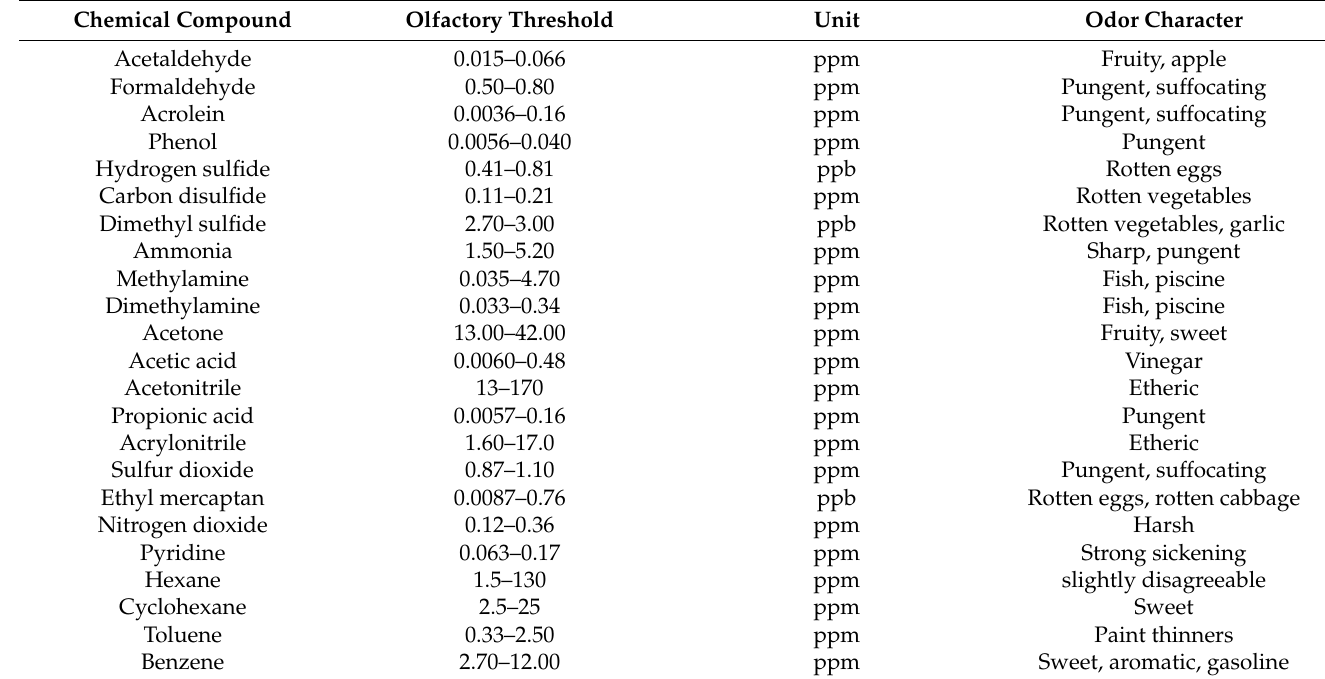
Table 1. The olfactory threshold for exemplary odorants